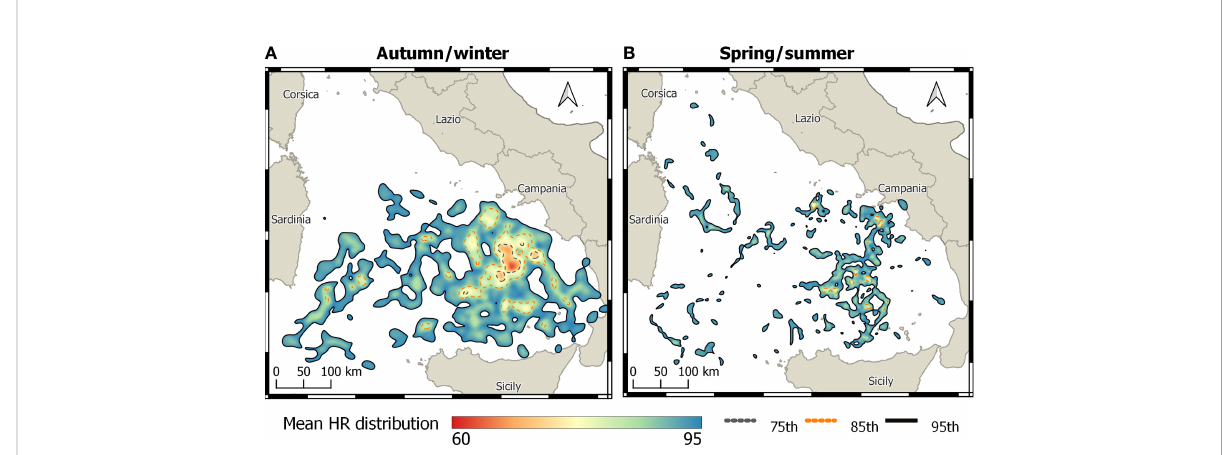
FIGURE 3 Seasonal average home range distributions of loggerhead turtles during (A) autumn/winter (n = 11) and (B) spring/summer (n = 12) semesters (number of observations of 2,904 and 1,781,